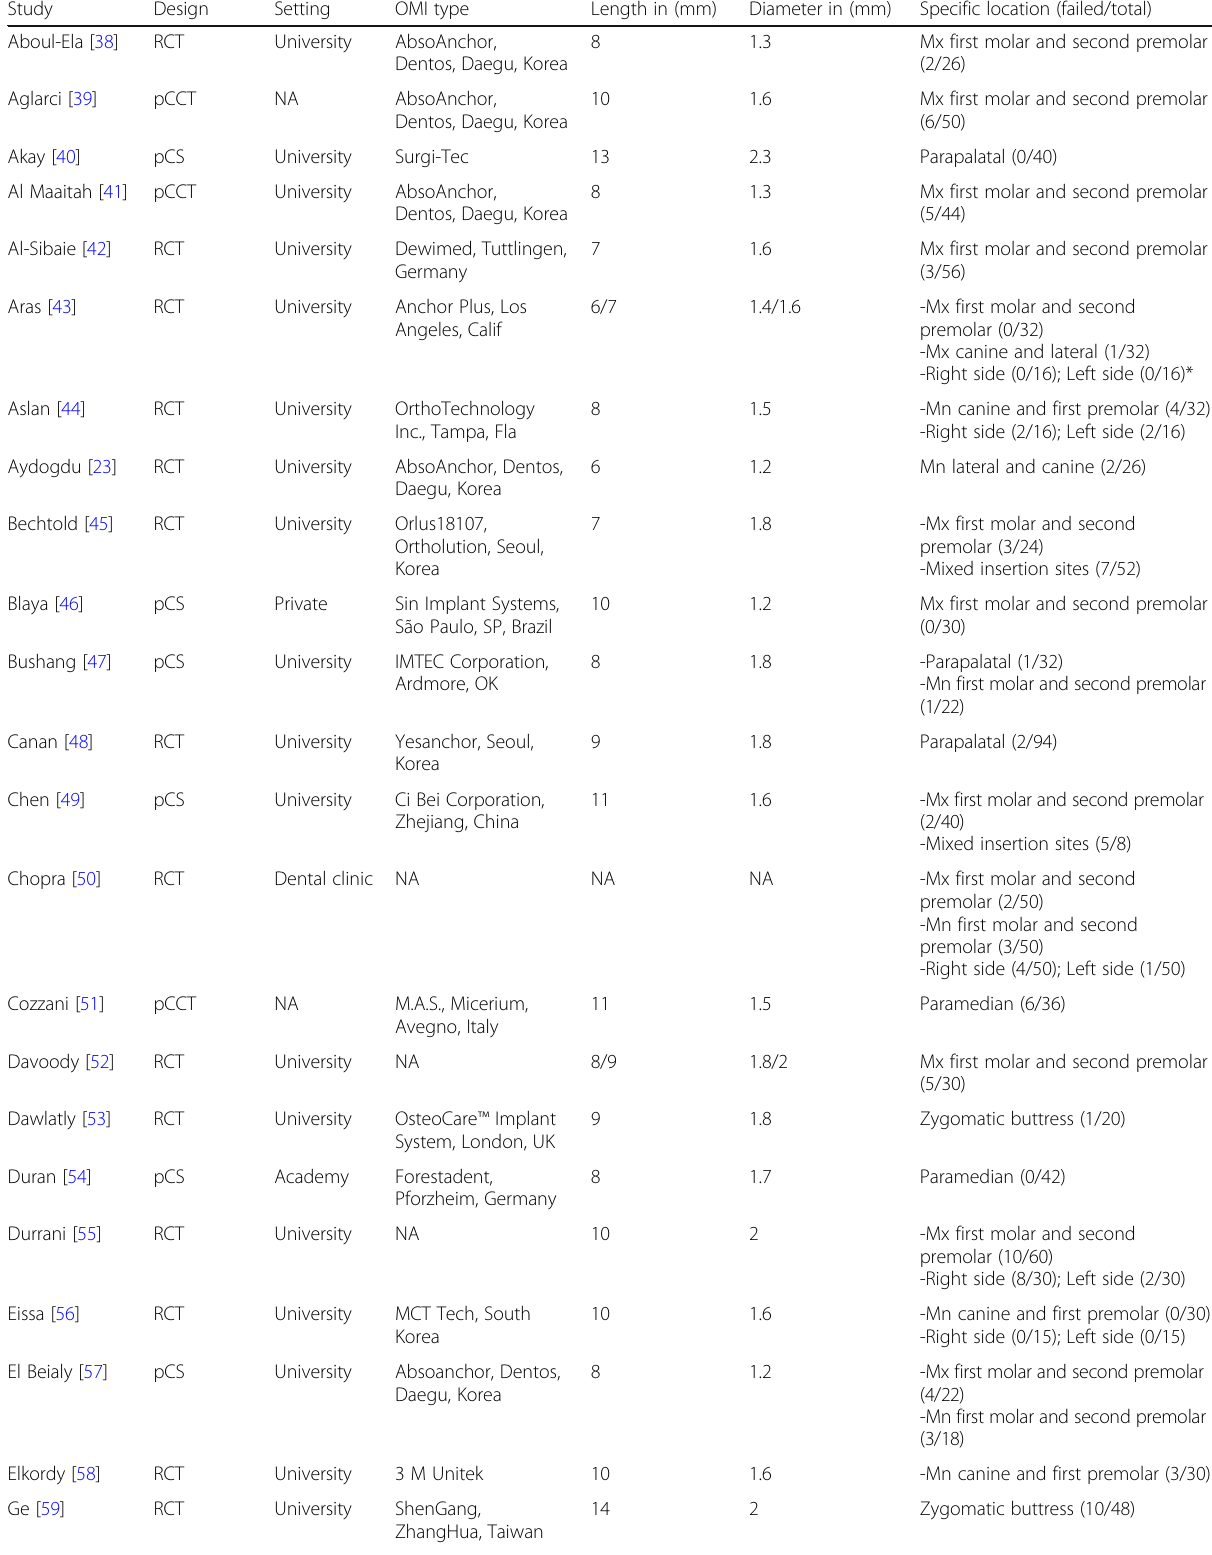
Table 1 Characteristics of the included studies